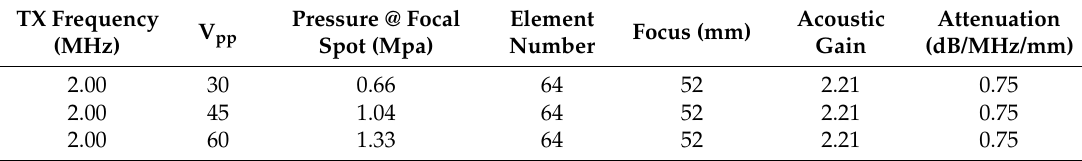
Table 1. Hydrophone measurement result of the 1D phased array lead zirconate titanate (PZT) probe. TX Frequency